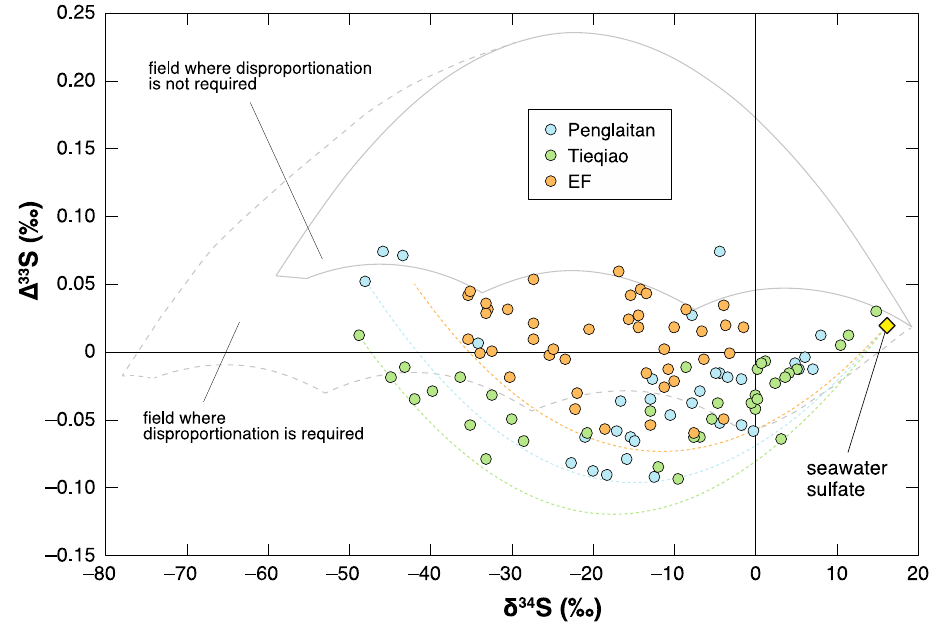
Figure 6. δ 34 S– ∆ 33 S cross plot at Penglaitan, Tieqiao, and EF [69]. The estimated δ 34 S and Δ 33 S values of contemporaneous seawater sulfate (+16.2‰ and +0.020‰, respectively) are from Wu et al. [68]. A convex downward curve is a possible mixing trend for each section.